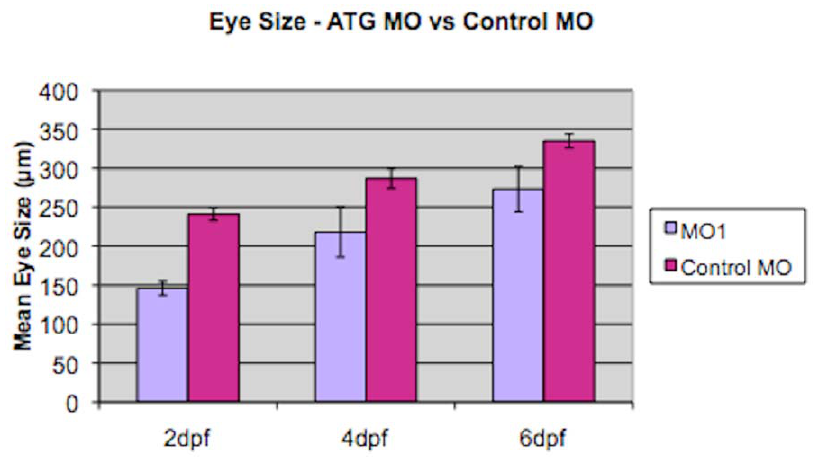
Figure 4. A comparison of eye size in MO1 morpholino-injected larvae and control-injected larvae. Graph shows mean eye size (measured in m m on y-axis) for MO1 morpholino-injected larvae (MO1; light purple) compared to control-injected larvae (Control MO; dark purple) at three different time periods, 2 dpf, 4 dpf and 6 dpf, labeled on the x-axis. Data are shown as mean + / 2 one standard deviation, measuring a minimum of 9–20 independent retinas per data point. Analysis using a Two-sample t-test assuming equal variance showed a significant difference at 2 dpf, 4 dpf and 6 dpf (p , 0.05 for 2 dpf, 4 dpf and 6 dpf).